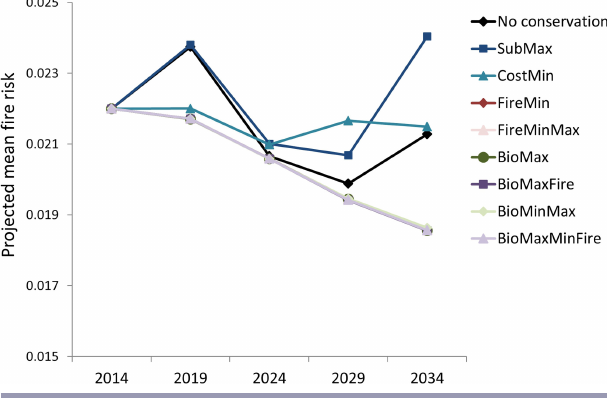
Fig. 2 . Mean projected fire risk to simulated structures across conservation strategies over time. Risk is defined as the probability of a structure being destroyed in a fire.